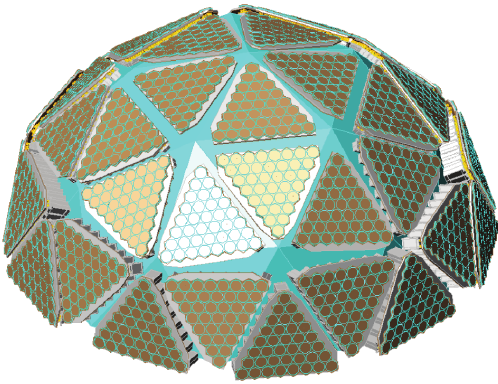
Figure 3: Faceted hemi-spherical